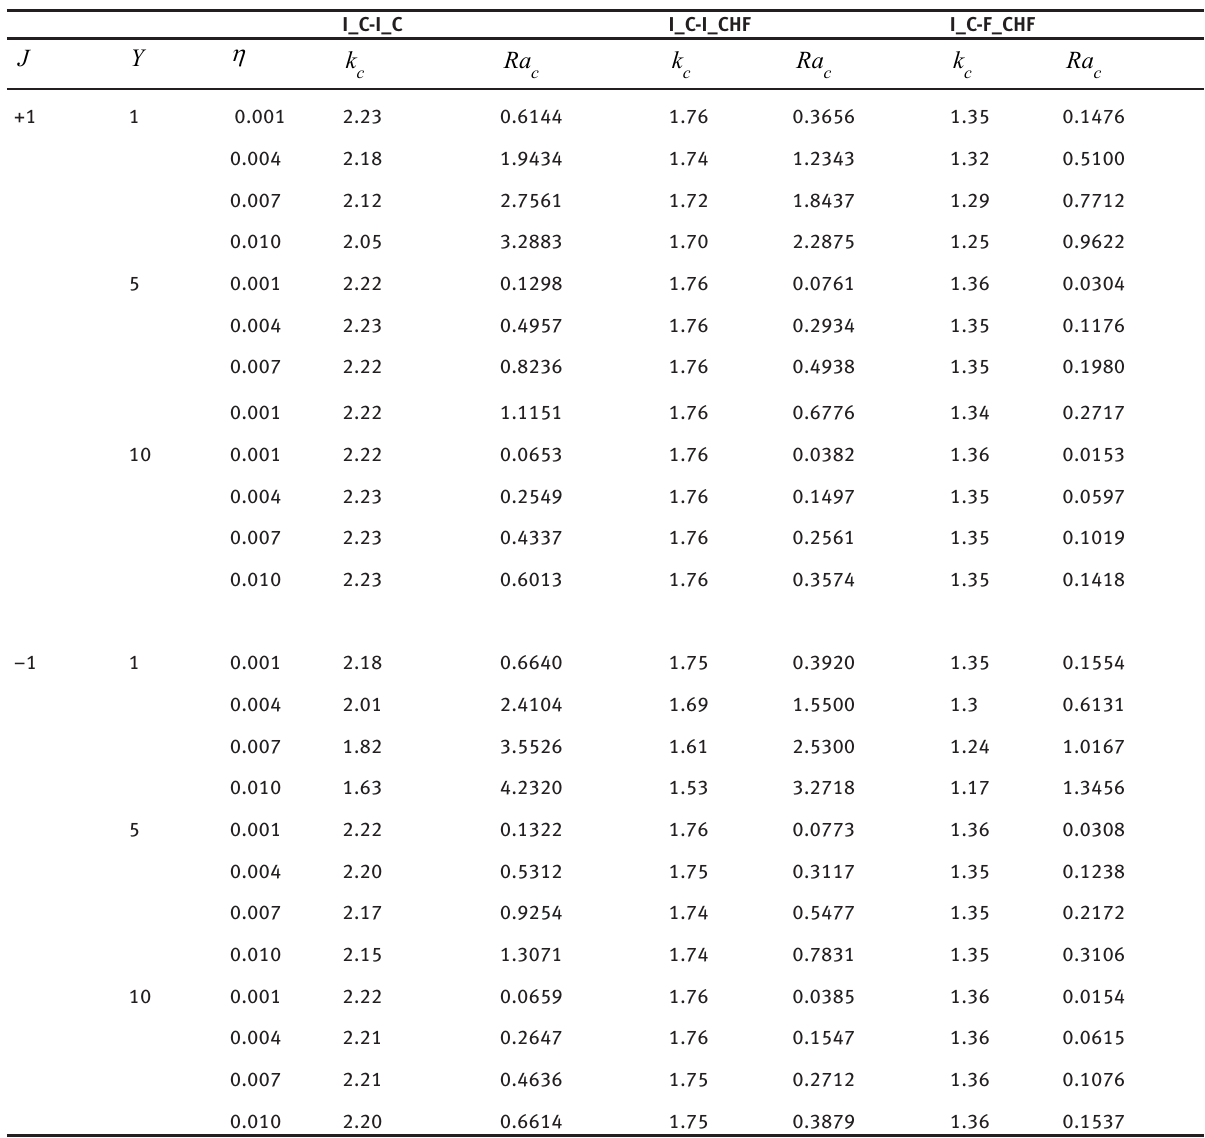
Ra for three different boundary c